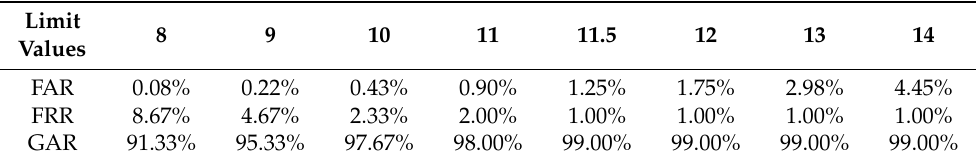
Table 1. FAR, FRR and genuine acceptance rate (GAR) obtained for the key length of 133 bits and varying absolute limit values.